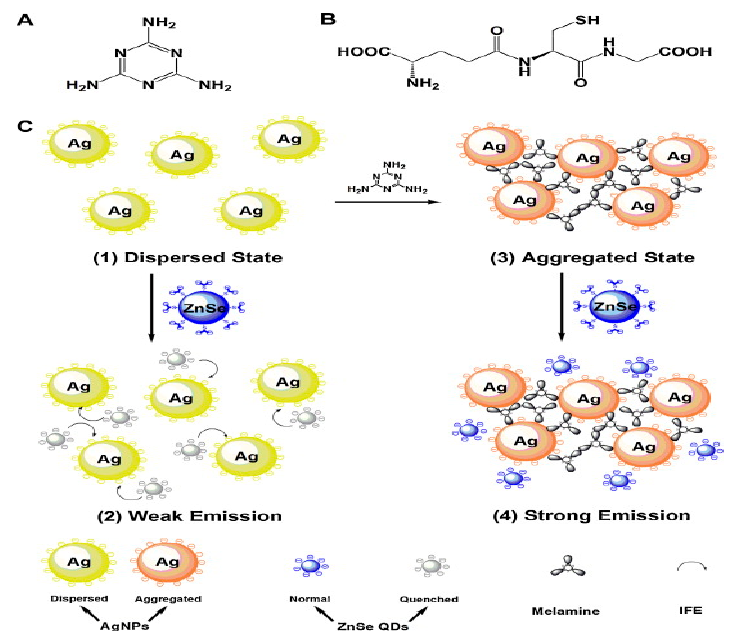
Figure 9. The molecular structures of melamine ( A ) and l-GSH ( B ); Schematic illustration of the “turn-on” fluorescent detection of melamine based on the inner filter effect (IFE) of AgNPs on ZnSe QDs ( C ) (reproduced with permission from Reference [63]).